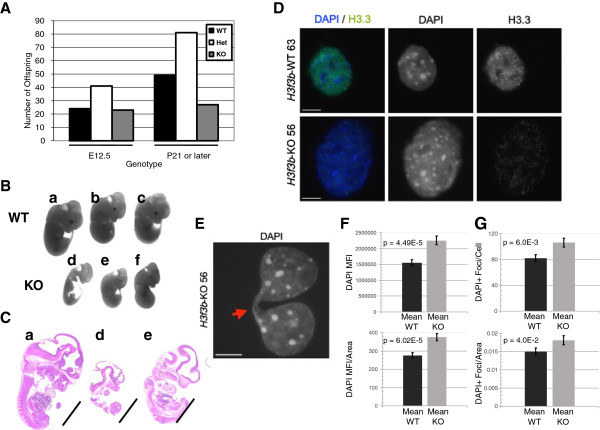
Loss ofH3f3bcauses a semilethal phenotype and in a subset of embryos strongly impairs overall growth. (A) Ratios of animals of the indicated ages from heterozygous intercrosses indicate substantial lethality among mature knockout (KO) animals.* 0.01 < P <0.05 by Chi Square. (B, C) KO E12.5 embryos exhibit strong reductions in overall growth. Scale bar = 1 mm. (D) Wildtype (WT) 63 and KO 56 E12.5 mouse embryonic fibroblasts (MEFs) stained with anti-H3.3 antibodies show higher levels of H3.3 in WT MEFs. (E) Chromosomal bridges were observed much more frequently in KO nuclei than in WT nuclei. DAPI staining of a KO 56 nuclei shows representative example of a KO chromosomal bridge. (F) H3f3b KO MEFs exhibit a statistically significant 1.45 to 1.5-fold increase in DAPI mean fluorescence intensity (MFI) per nuclei, and a 1.21 to 1.36-fold increase in the amount of DAPI MFI per unit of nuclear area. (G) H3f3b KO MEFs display a significant 1.30 to 1.5-fold increase in the number of pericentric heterochromatic DAPI foci per nuclei, and a significant increase in the number of DAPI-positive foci per unit of nuclear area. Scale bars = 10 um.